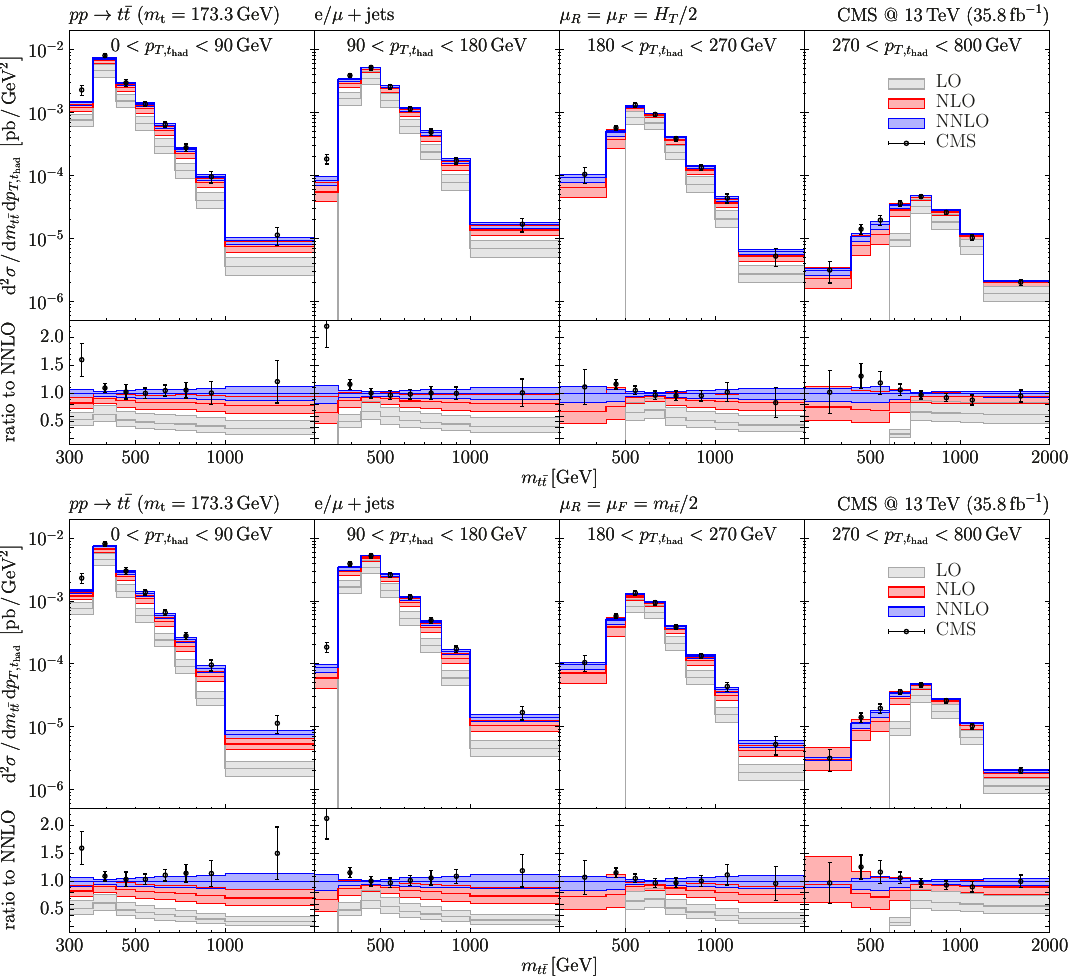
Figure 8 . Double-di(cid:11)erential cross sections as a function of m data [9] and LO, NLO and NNLO results for central scales H T = 2 (upper) and m t (cid:22) t = 2 (lower).